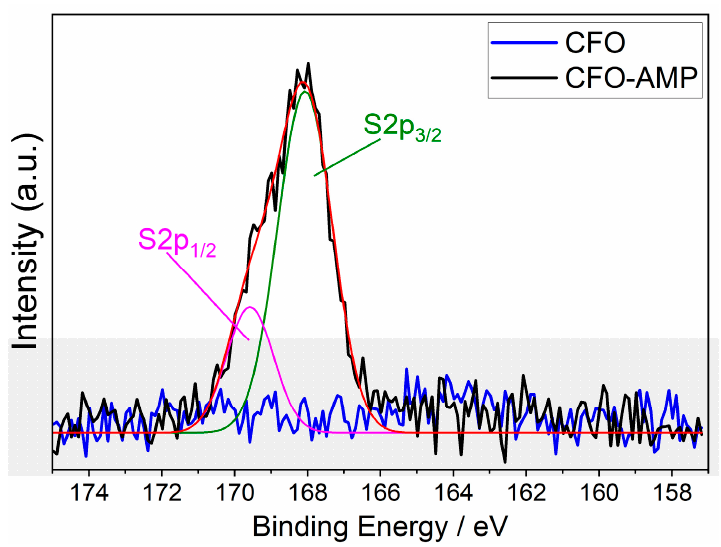
Figure 3. Background ‐ subtracted XPS spectra region of S2p comparing CFO and CFO ‐ AMP.